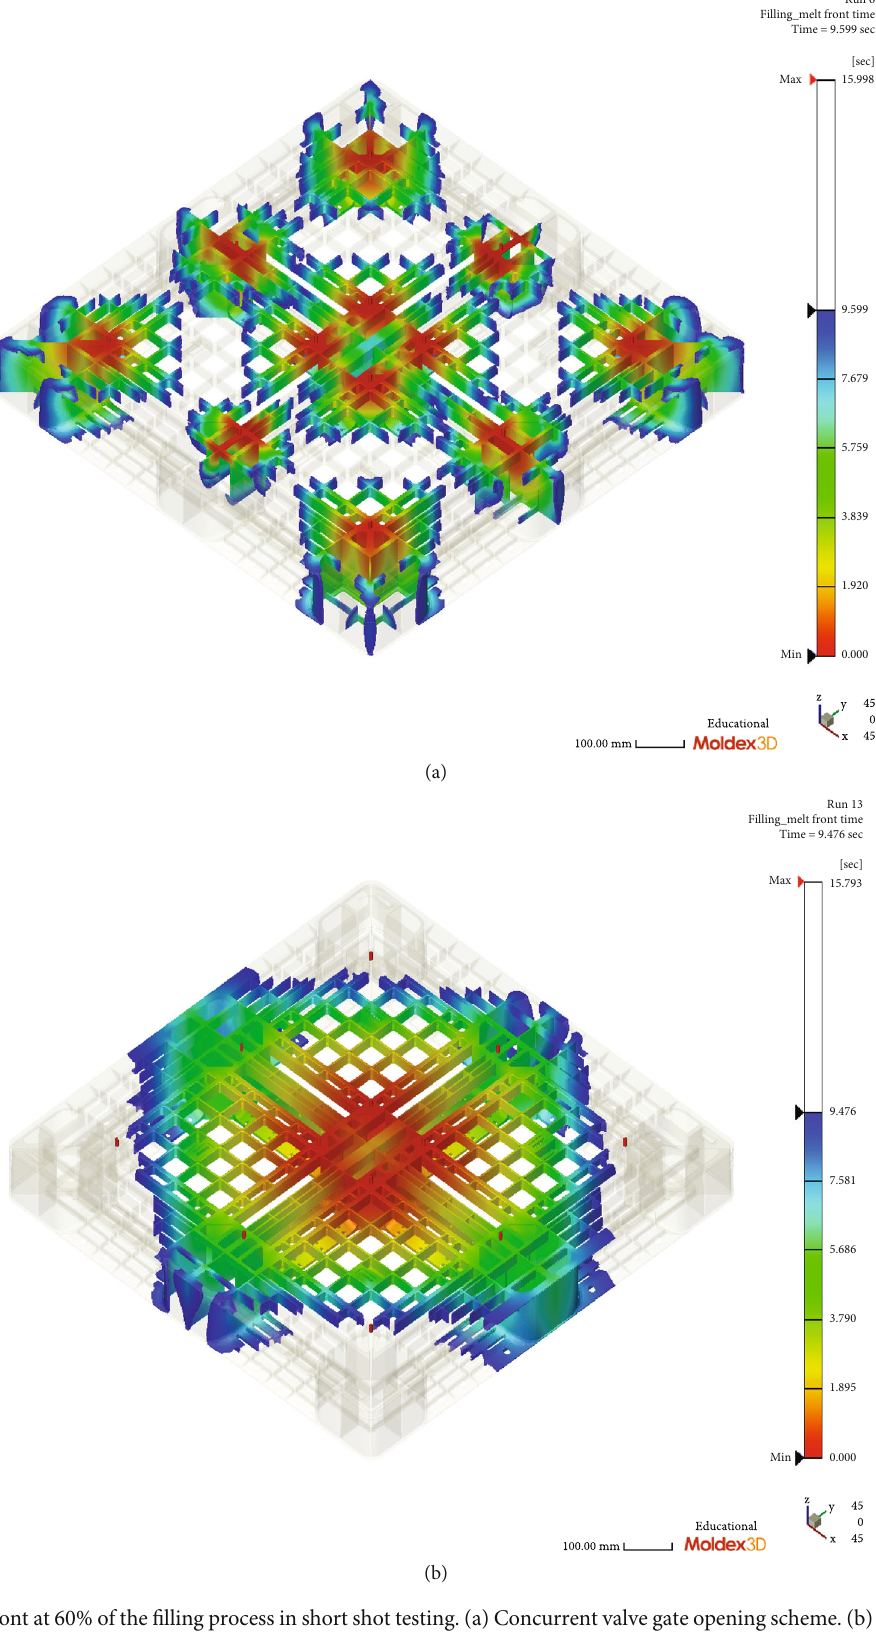
Figure 4: The fl ow front at 60% of the fi lling process in short shot testing. (a) Concurrent valve gate opening scheme. (b) Sequential valve gate opening